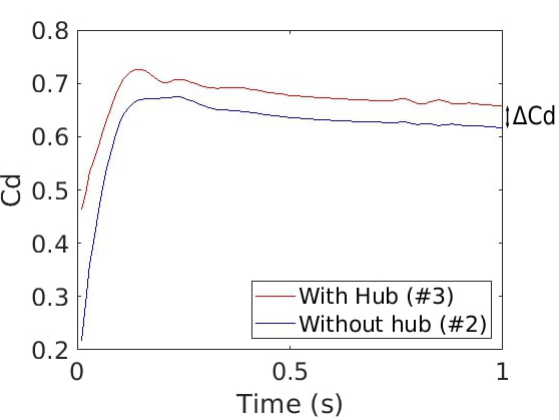
Figure 20. C d time evolution for the cases with (#3) and without a hub (#2.0).